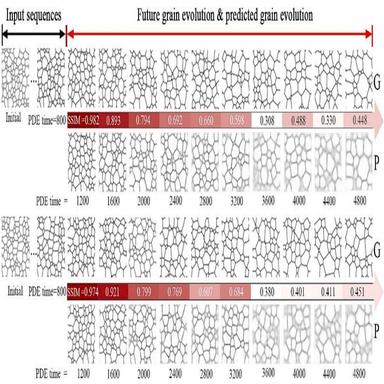
Examples of output frames predicted by the trained model based on the first 10 input frames. G and P indicate ground truth and prediction. SSIM: structural similarity index measure.